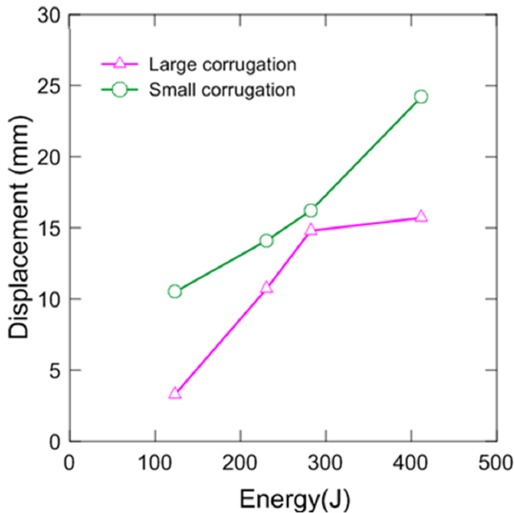
Figure 7. Comparison of displacement between large and small corrugation in accordance with impact energy.